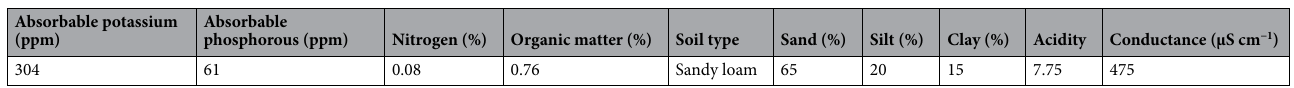
Table 7. The properties of soil in the experimental